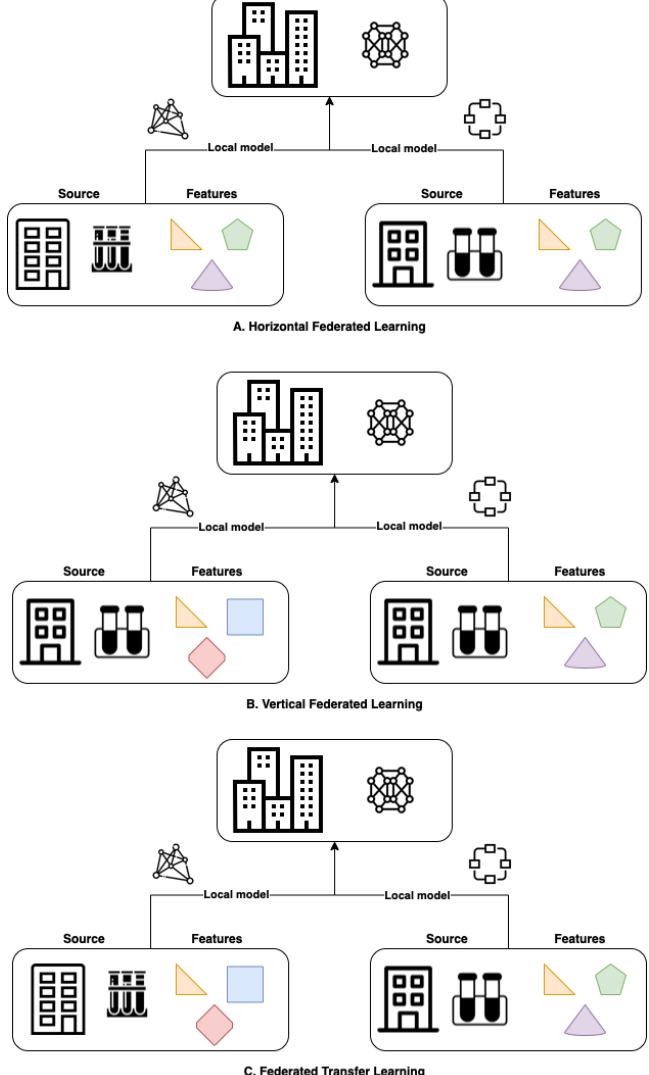
Figure 4. Data partition of horizontal federated learning, vertical federated learning, and federated transfer